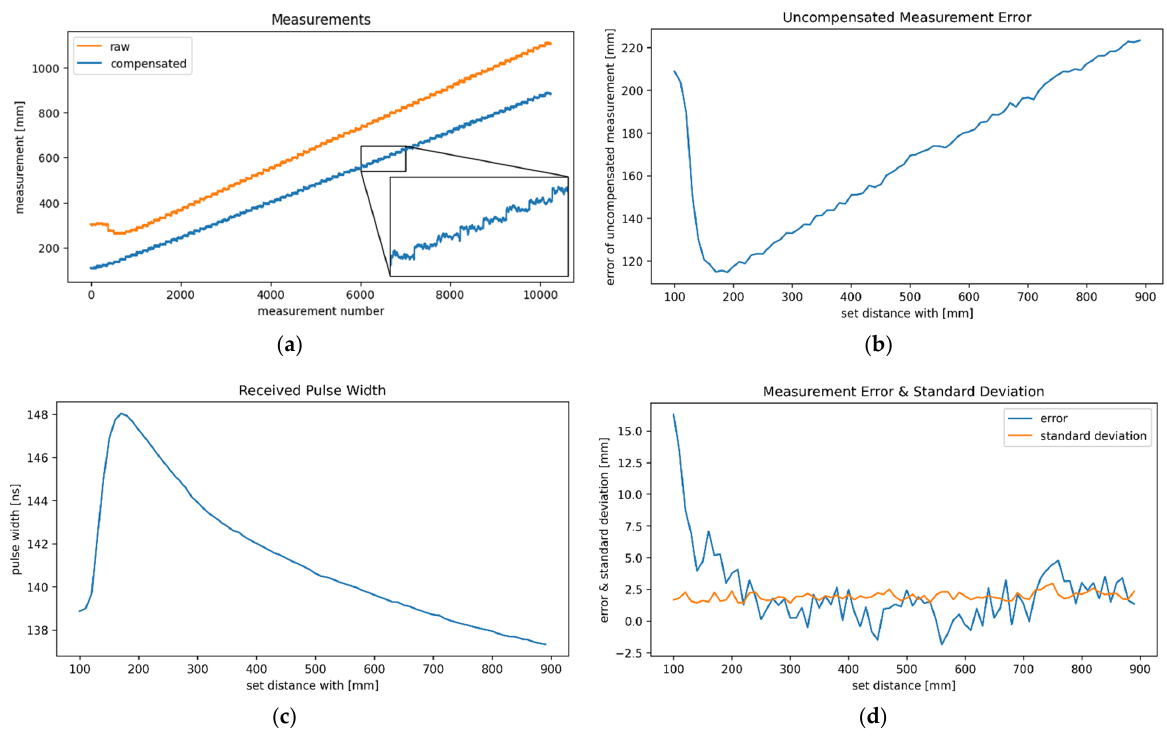
Figure 7. ( a ) shows raw and compensated measurements, ( b ) depicts errors of uncompensated measurements, ( c ) reflected pulse width, and ( d ) errors and standard deviations of compensated measurements in blue and orange,